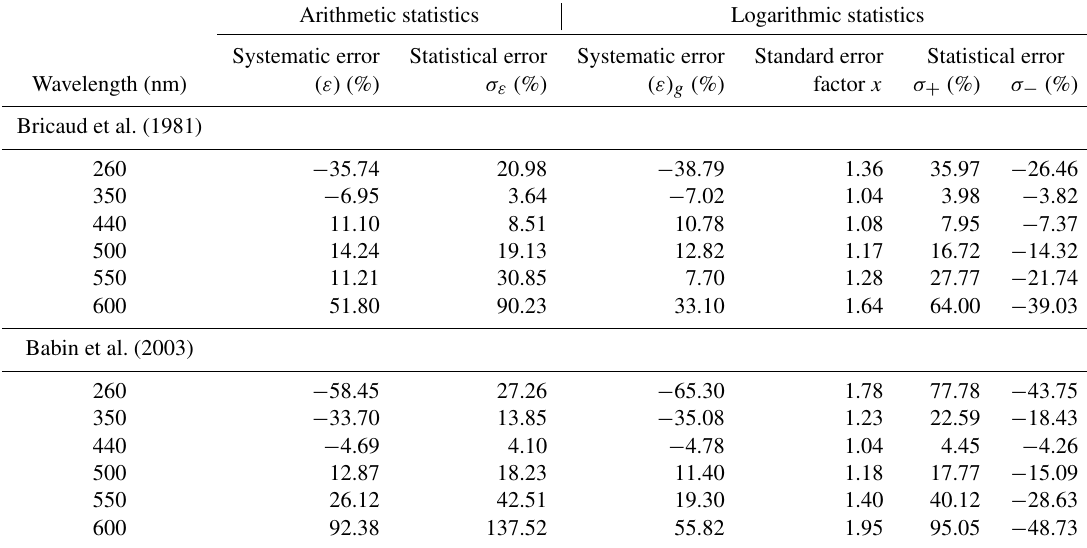
Table 6. Relative errors of the models of Bricaud et al. (1981) and Babin et al. (2003) for determining spectral values of CDOM absorption coefficients ( a CDOM (λ)) at selected